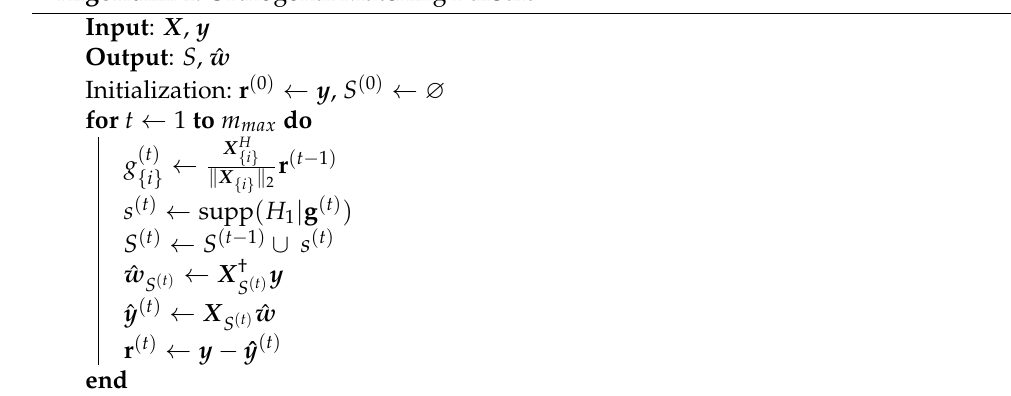
Algorithm 1: Orthogonal Matching